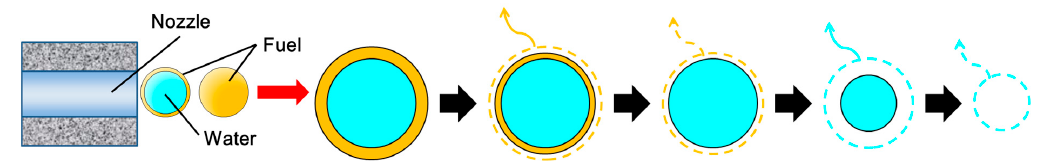
Figure 9. Fuel–water evaporation model process.